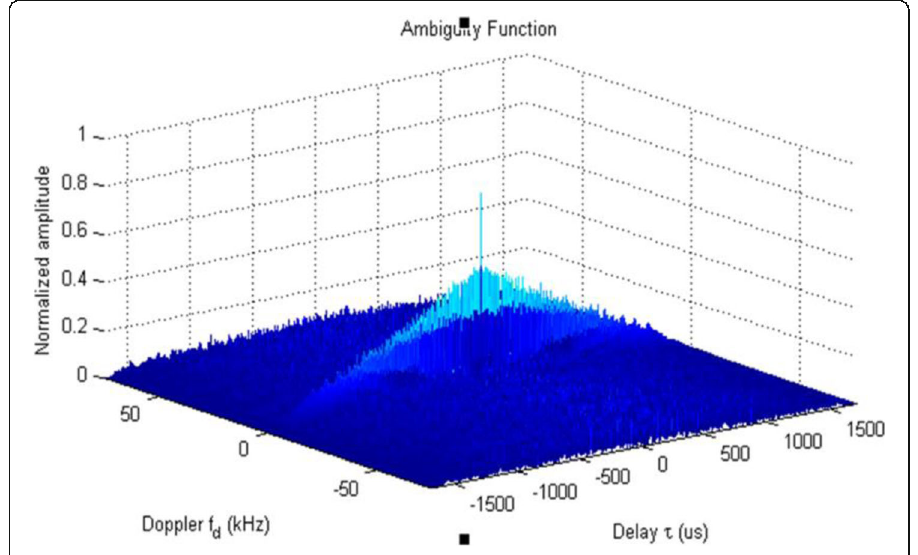
Fig. 14 Doppler tolerance of f C